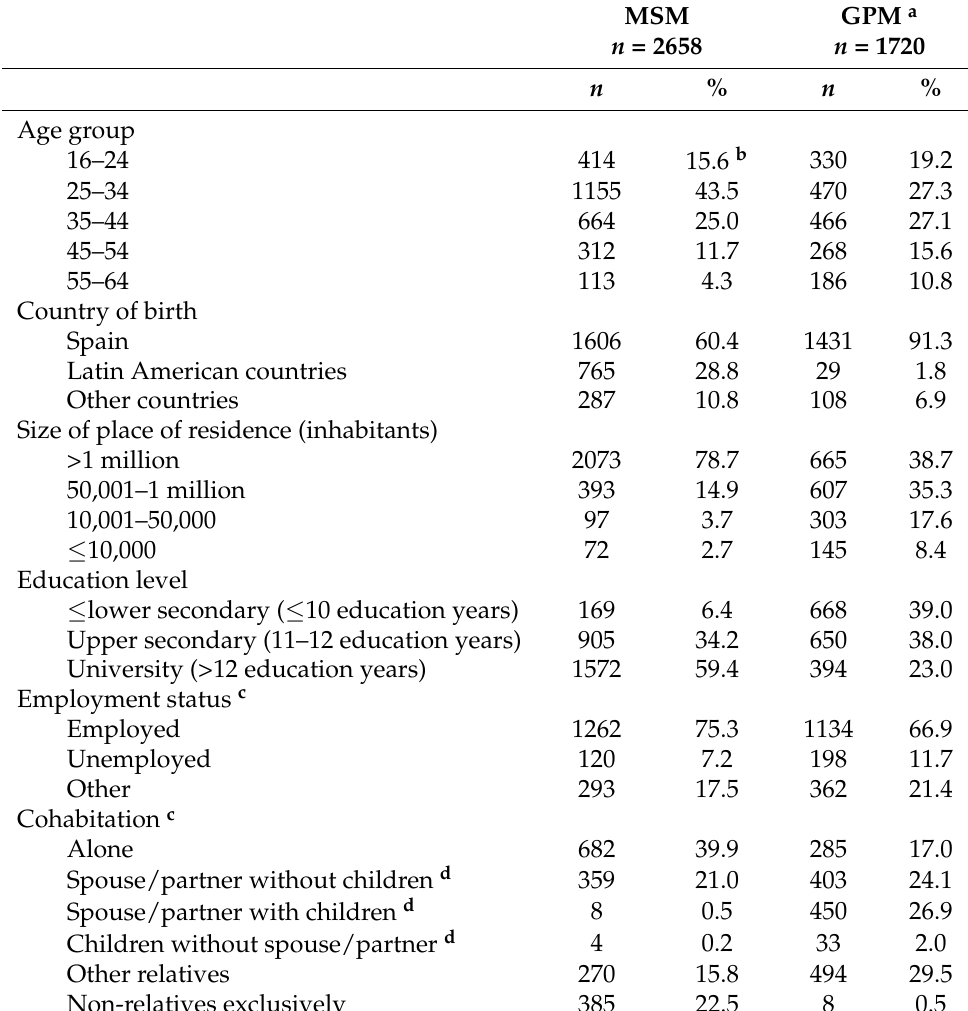
Table 1. Comparison of sociodemographic characteristics between men who have sex with men (MSM) and general population men (GPM) in Madrid and Barcelona, 2018–2020